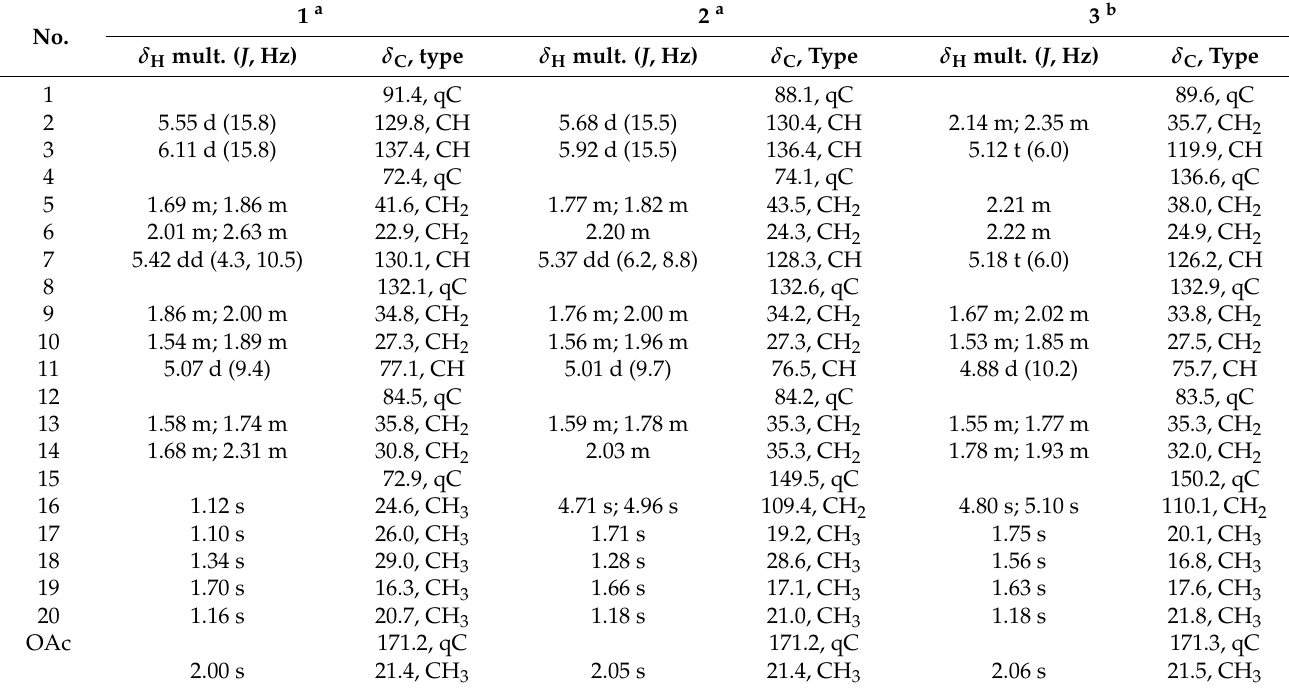
Table 1. 1 H NMR and 13 C NMR data for compounds 1–3 .